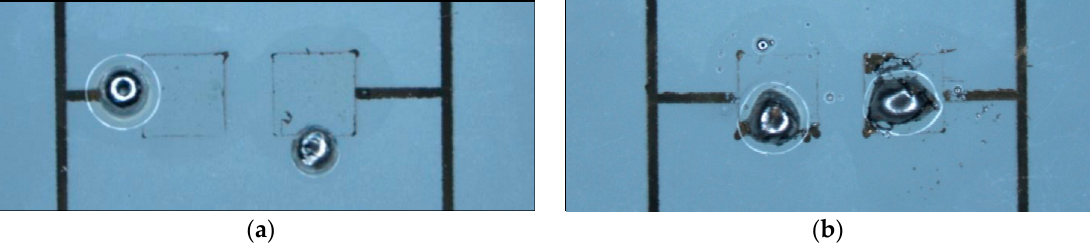
Figure 9. Hot air soldering with SAC solder on printed Ag structures (ink: Sicrys I30 EG-1) on 2D test substrates (Luxaprint 3D mold) at 255 °C ( a ) and with SnBi solder at 180 °C ( b ). Pads fabricated by aerosol printing of two layers with a thickness of approx. 0.4 µm were dissolved by SnBi solder almost immediately (Figure 10). Residues of the pad’s edges can still be noticed. The results are similar to those obtained on inkjet-printed pads [28,31] where almost all contact pads had conductor breaks after soldering with SnBi solder due to dissolving of the tracks in the soldering paste.